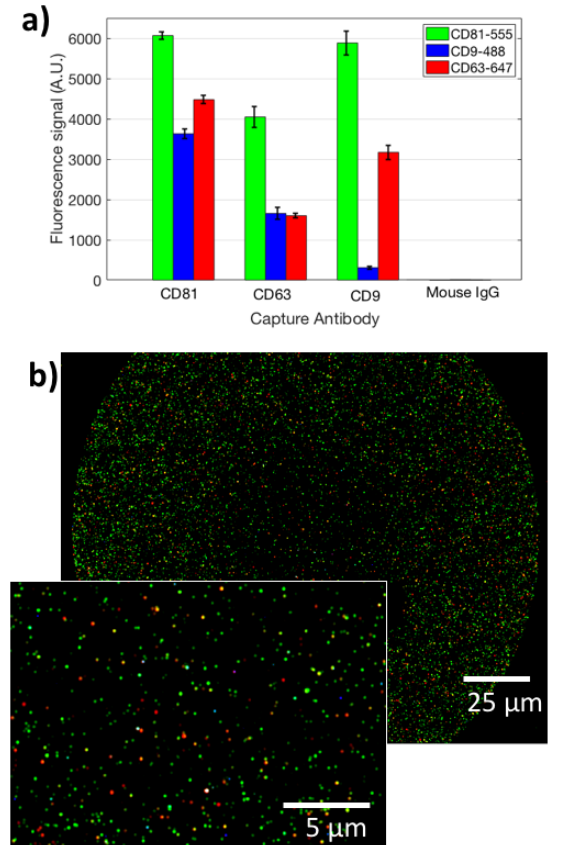
Figure 2. ( a ) The fluorescence signal obtained for the analyzed EVs from staining with three different labeled antibodies (aCD81-555, aCD9-488, aCD63-647), on three different capture spots (aCD9, aCD81, aCD63). ( b ) A co-localized fluorescence image of EVs captured on immobilized aCD9. Green points refer to CD81 staining, blue to CD9, red to CD63. The inset shows a zoomed-in image of the same